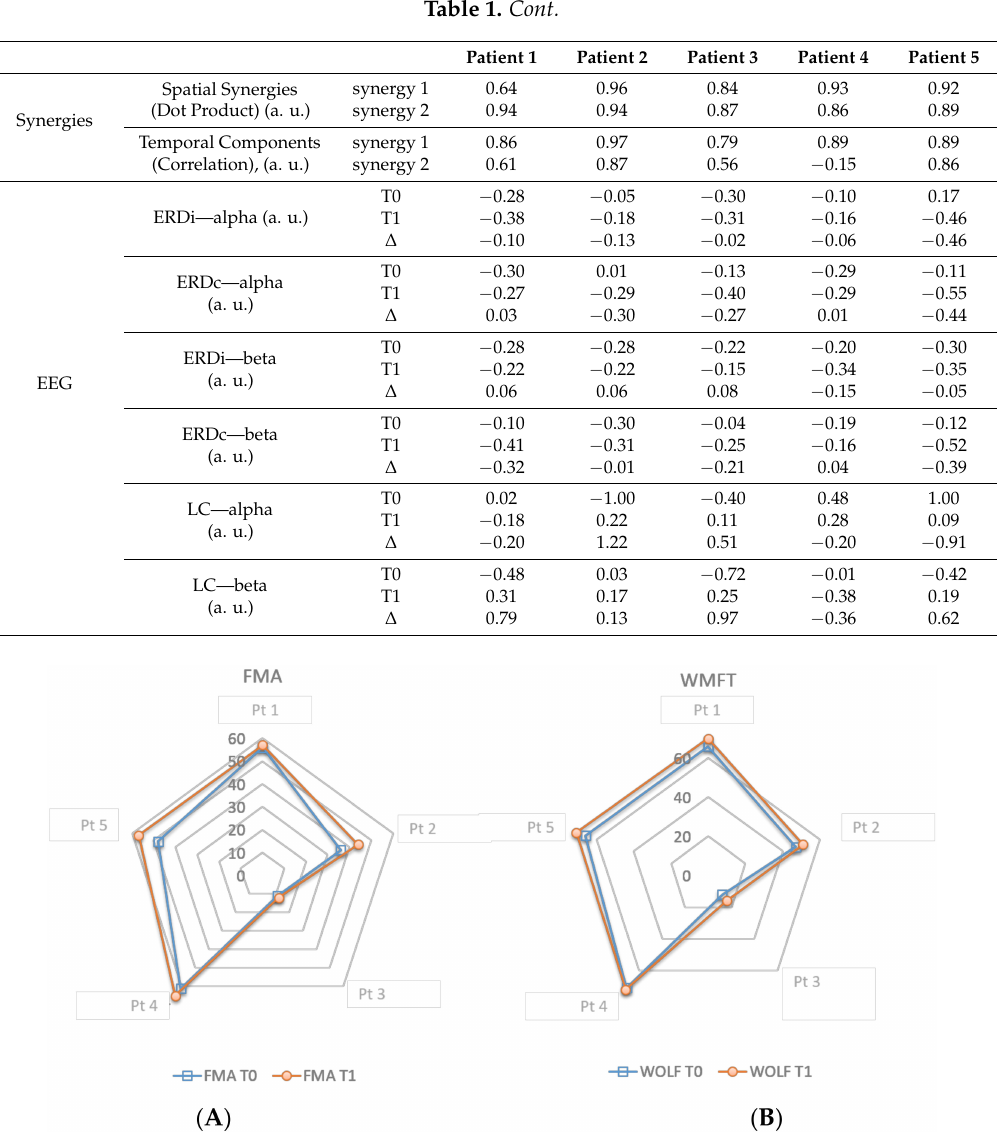
Figure 2. Radar plots of the patients’ scores for the two clinical scales (FMA, ( A ); WMFT, ( B )) at T0 (blue line) and T1 (red line). FMA, Fugl–Meyer Assessment; WMFT, Wolf Motor Function